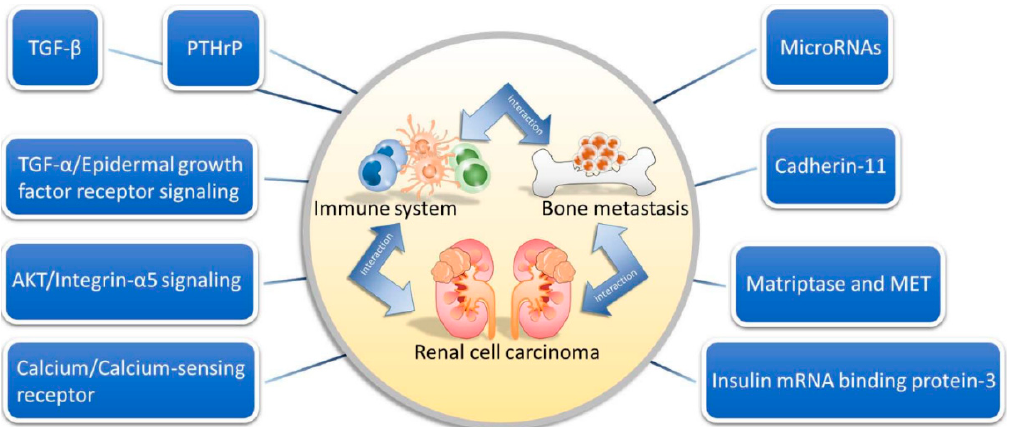
Figure 1. The molecular players in renal cell carcinoma.